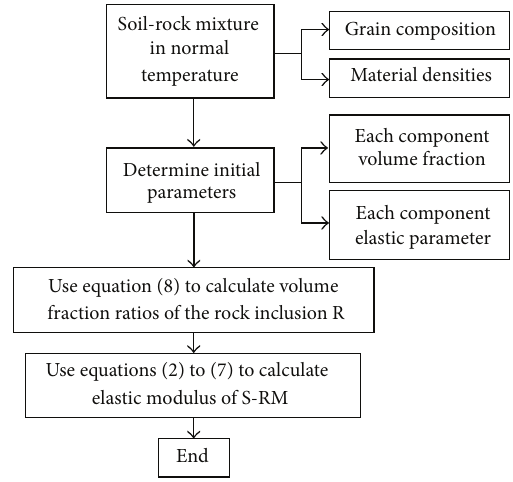
Figure 5: Flowchart of the calculation of the elastic modulus of soil- rock mixture.